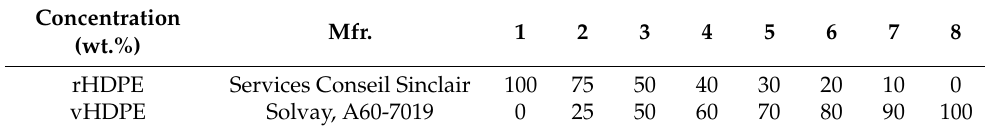
Table 3. Manufacturing (Mfr.) information and proportion of virgin/recycled HDPE during mixing. Concentration Mfr. (wt.%)